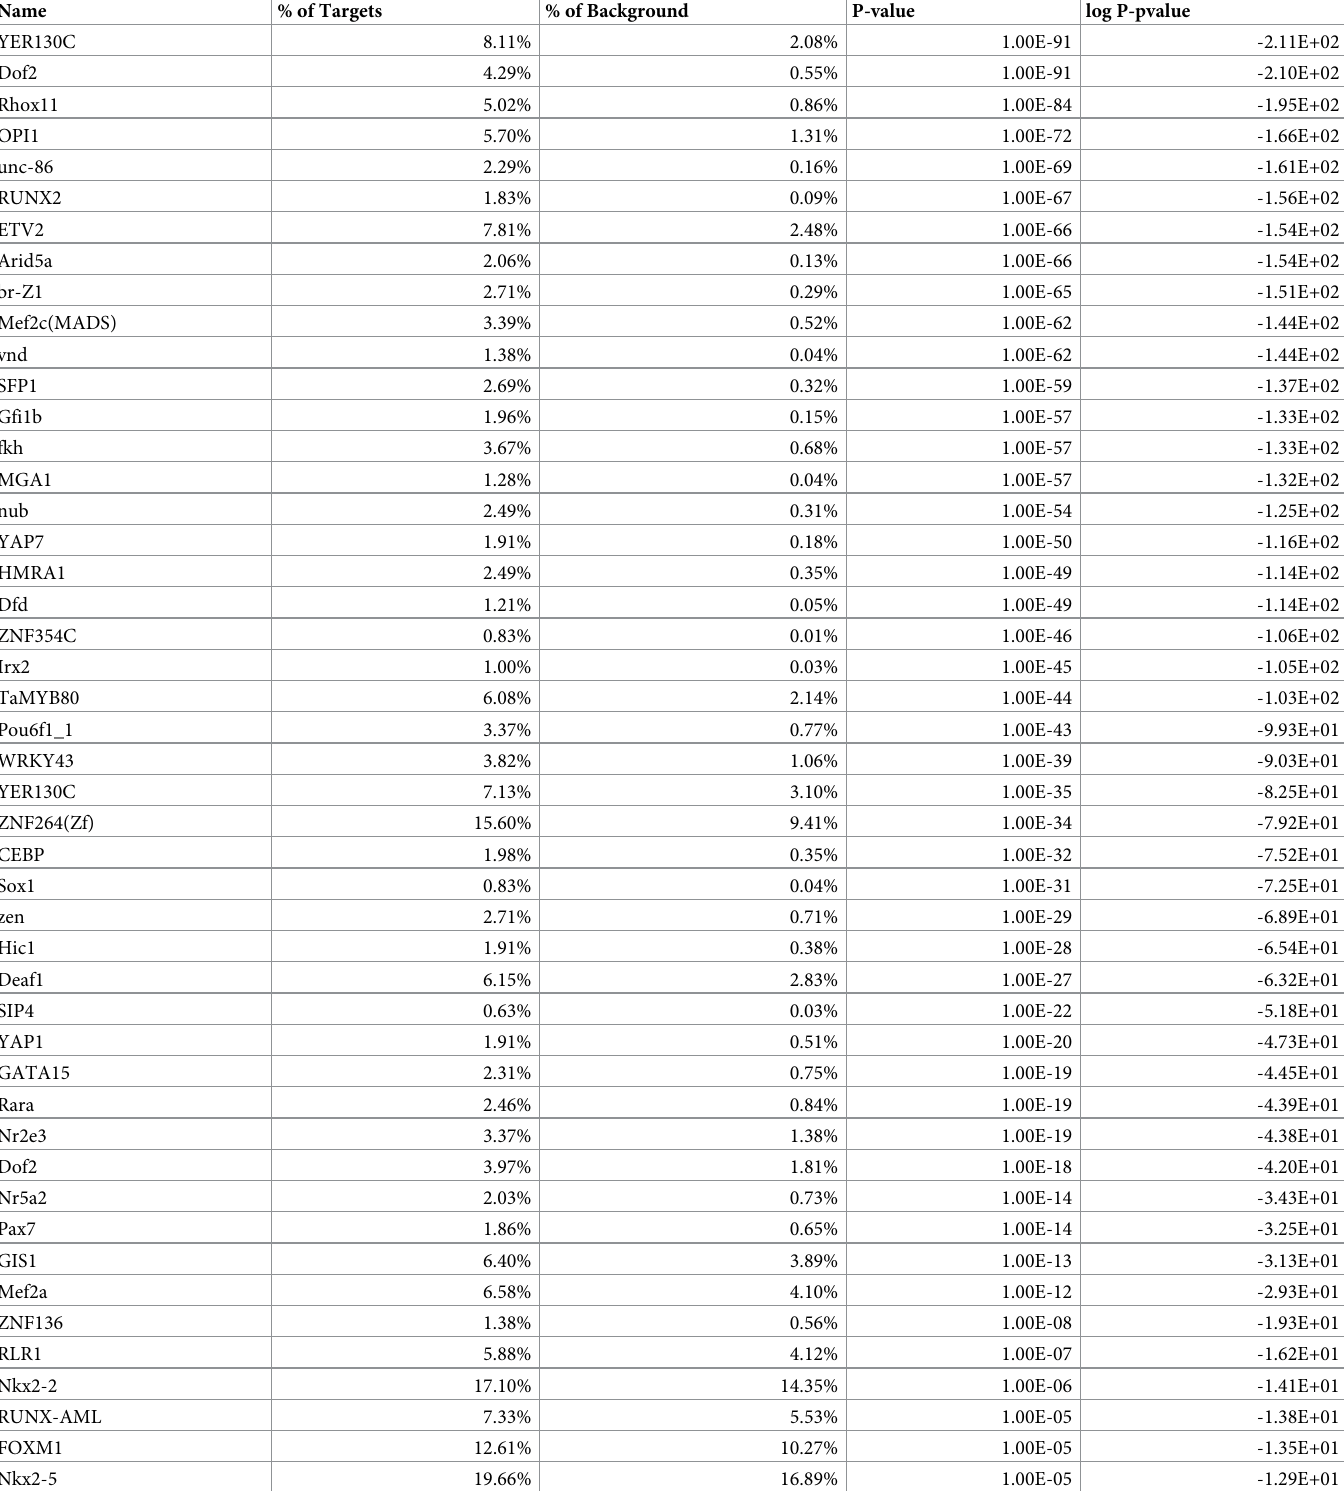
Table 5. DD enriched